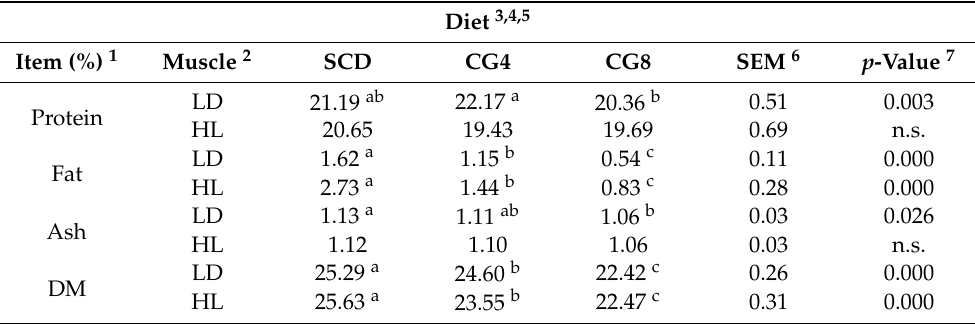
Table 2. Impact of freshwater C. glomerata biomass inclusion in the diet of rabbits on the chemical composition of different rabbit muscles. Diet